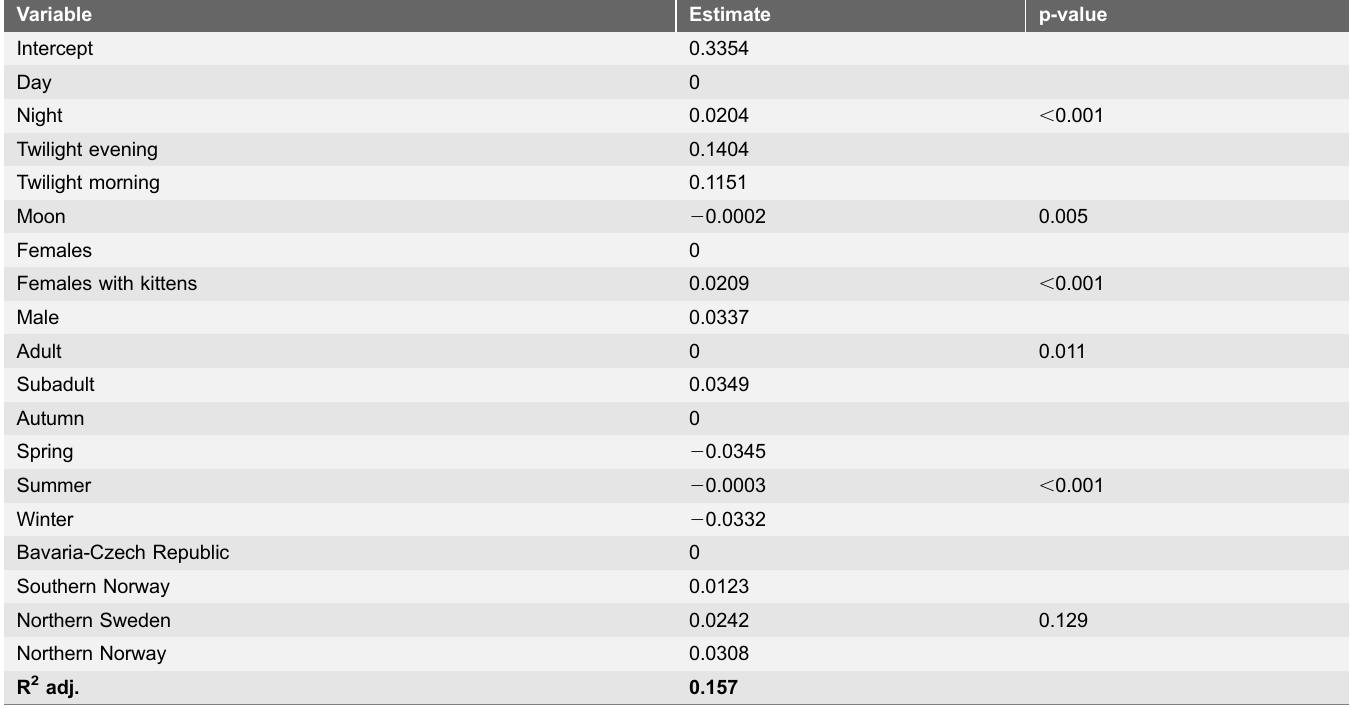
Table 3. Results of the linear mixed additive model with the response variable set to the percentage of time active per hour.